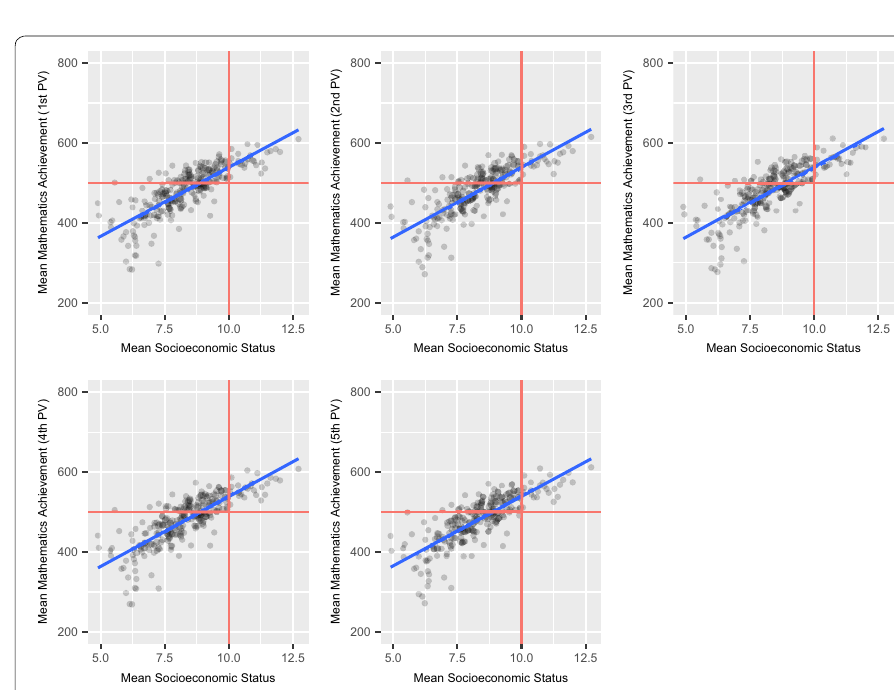
Fig. 2 Association between school-level SES and mathematics achievement by plausible